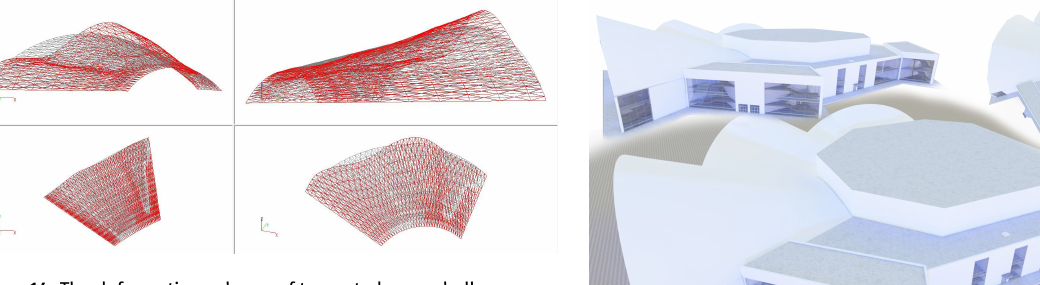
Figure 14: The deformation scheme of truncated cone shell